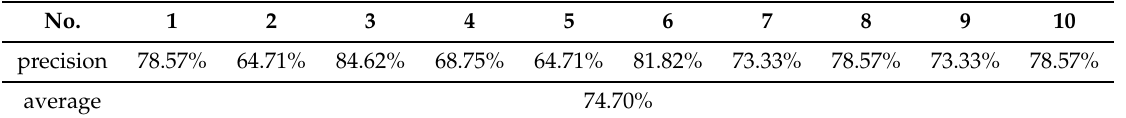
Table 1. The judgment precision of ten experiments and the average value of ten experiments.